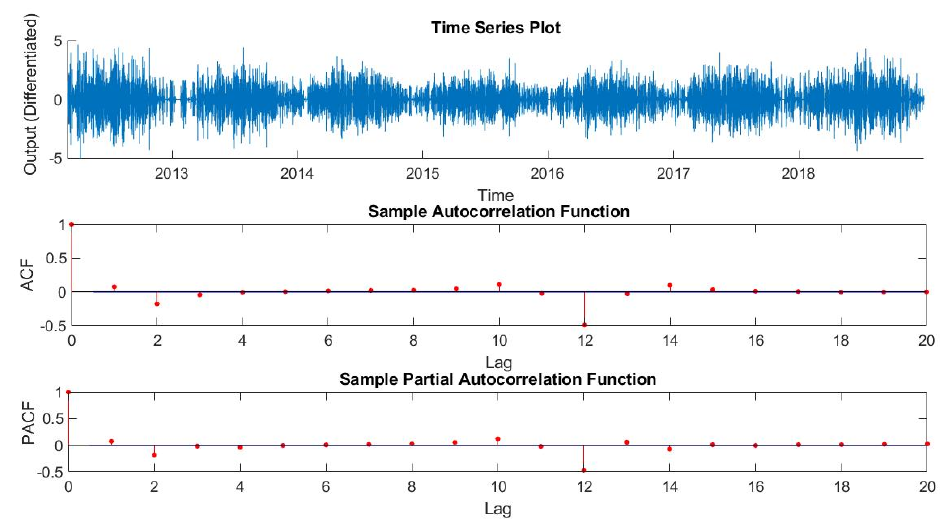
Figure 4. Solar panel output data with an auto correlation function (ACF) and a partial auto correlation function (PACF) analysis.